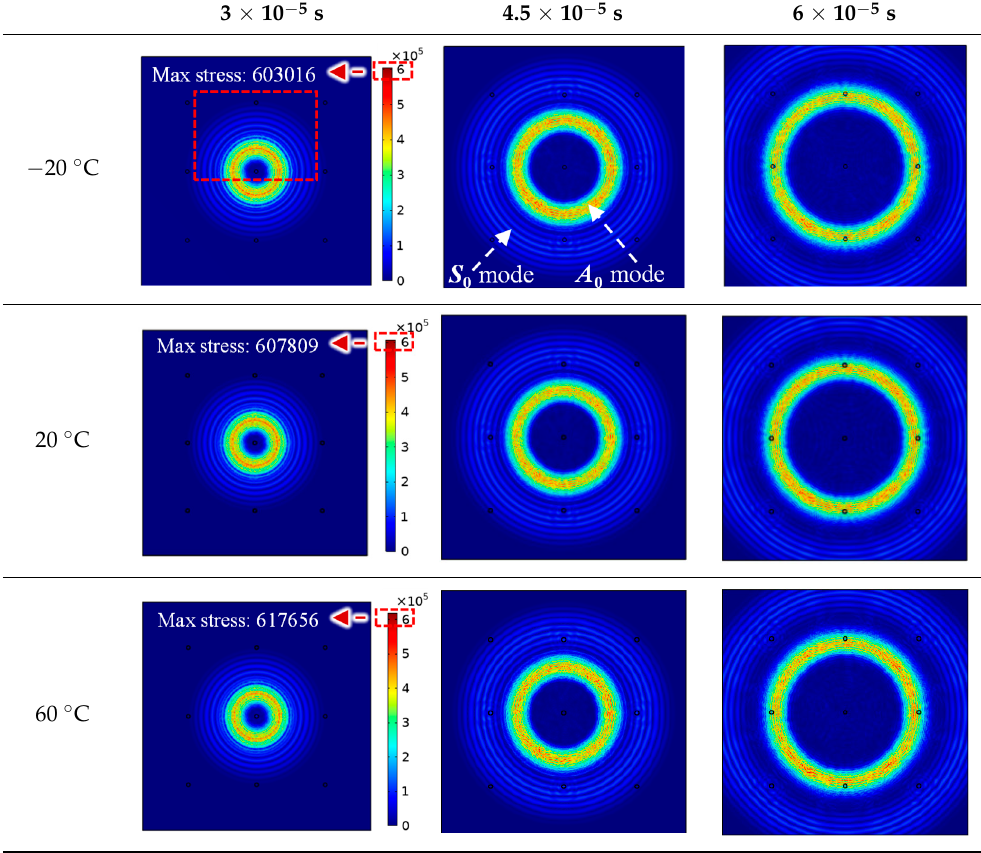
Figure 5. The effect of temperature on LW phase. The simulated LW signals under different temperatures are given in Figure 6, which are the LW signals of channel 5–6 when the center frequency of the excitation signal is 200 kHz. An enlarged view of S 0 mode is given to observe the changes in phase and amplitude better. It can be seen that the amplitude increases, and the phase delays with the increment of temperature.